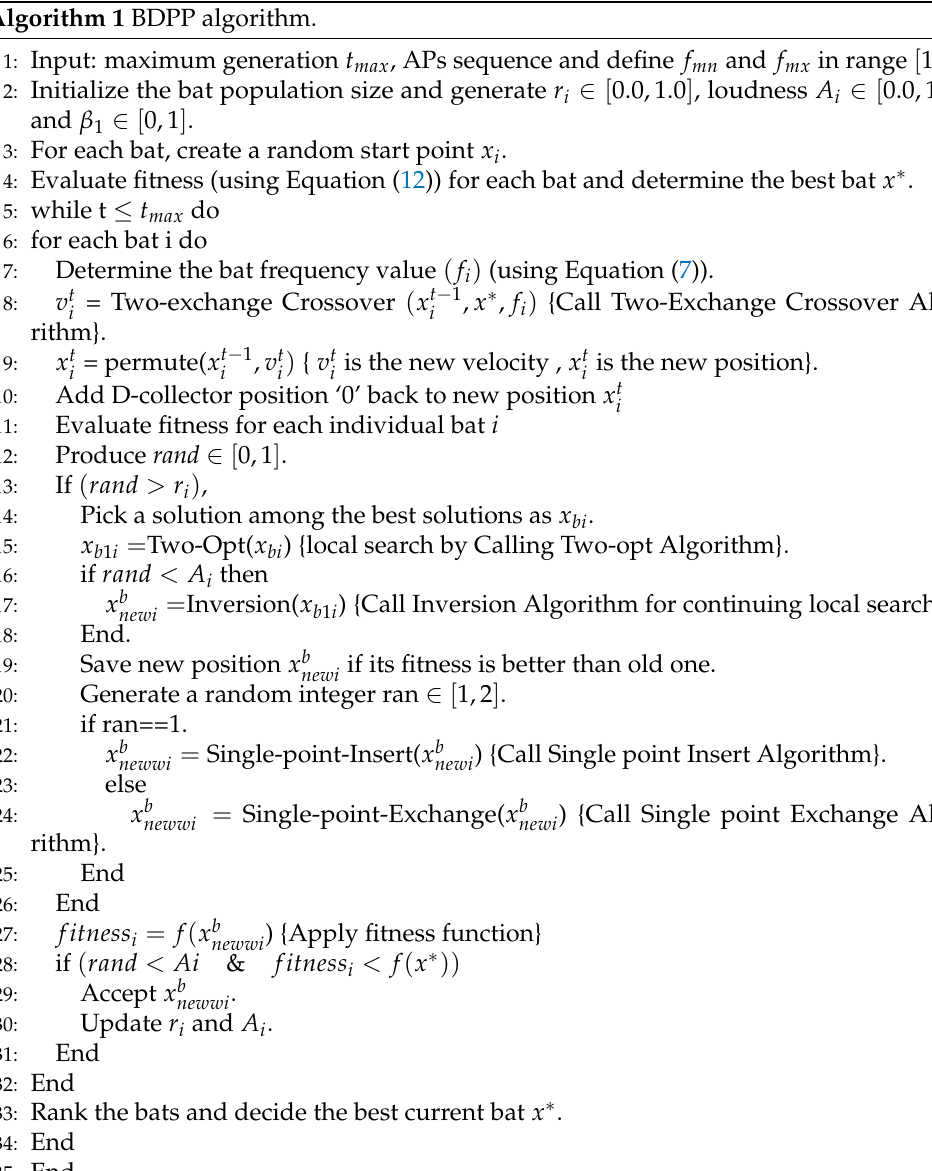
Algorithm 1 BDPP